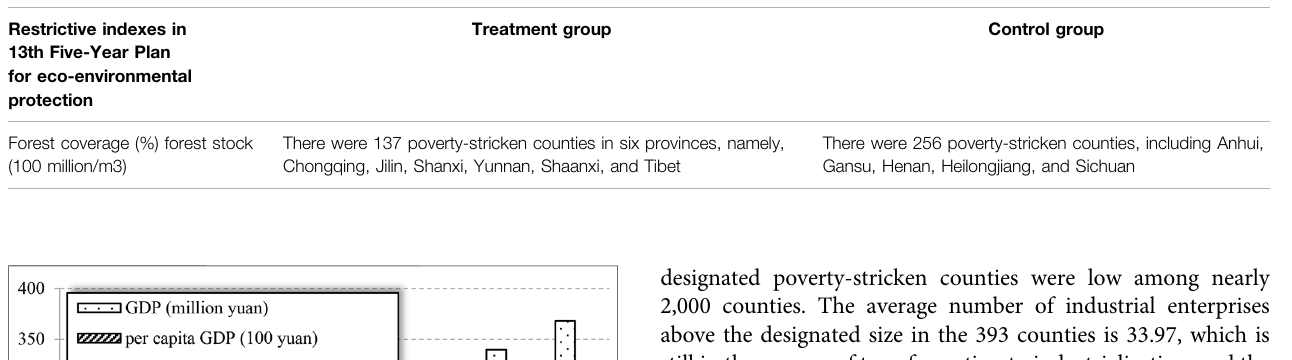
TABLE 1 | Treatment and control groups.